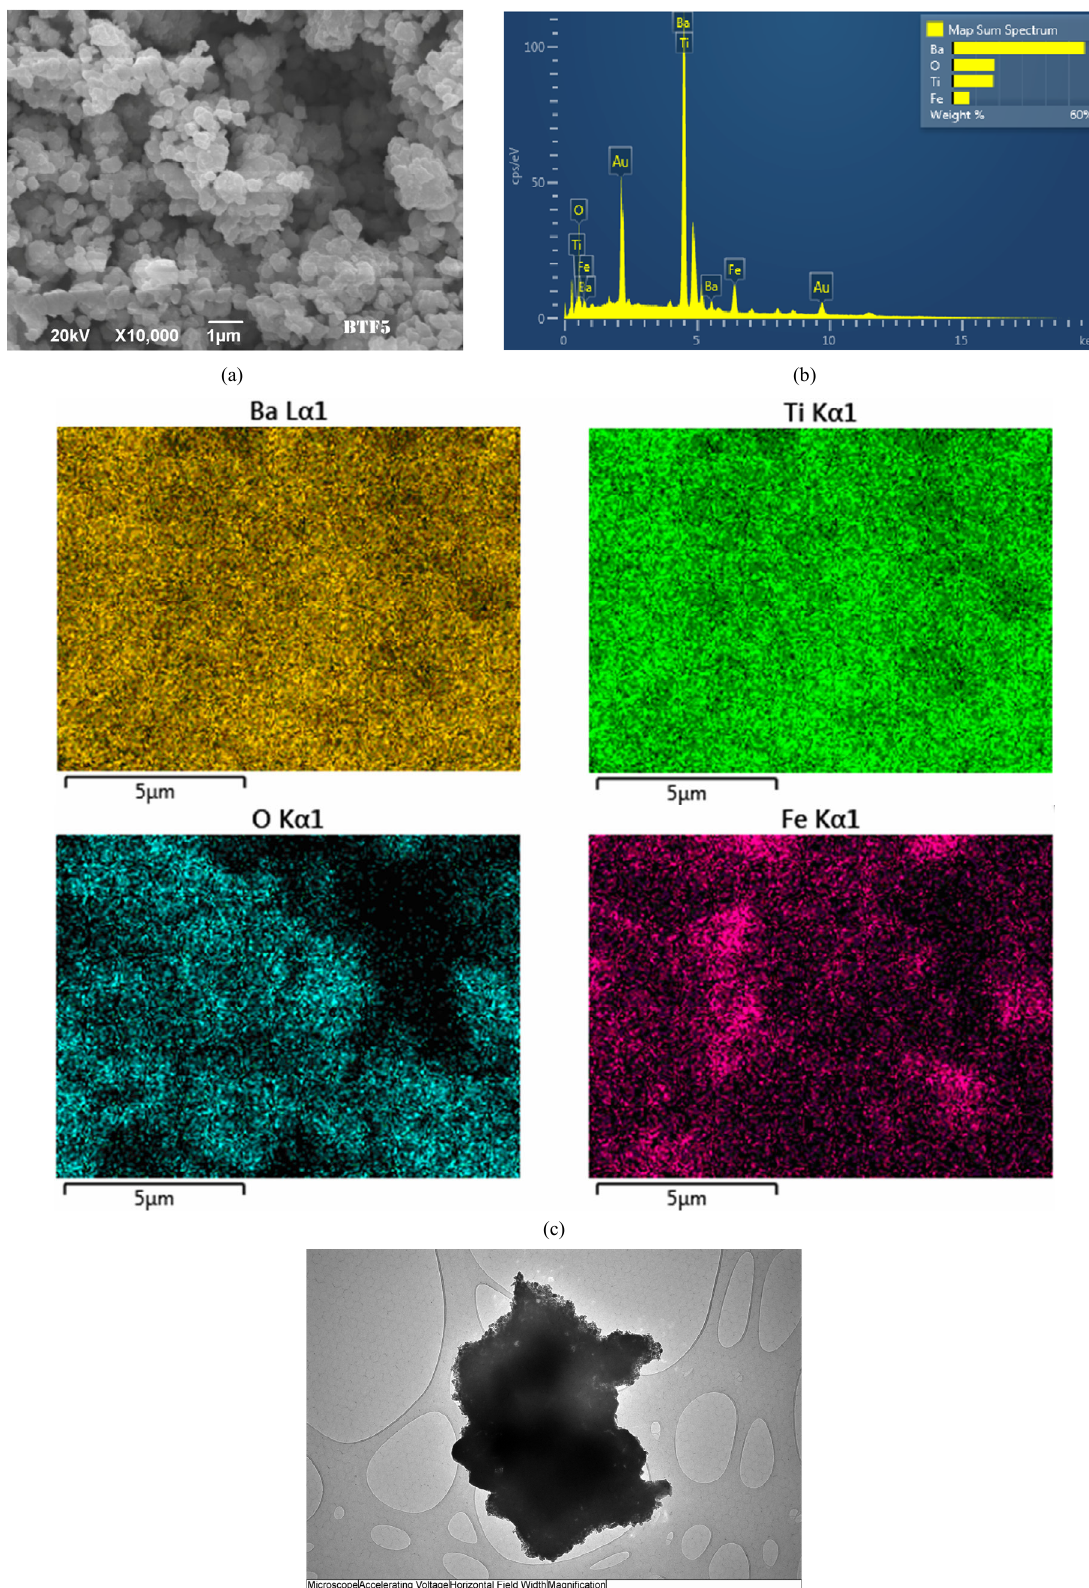
Fig. 8 (a) SEM; (b) EDS; (c) mapping of elements; (d) TEM for the sample